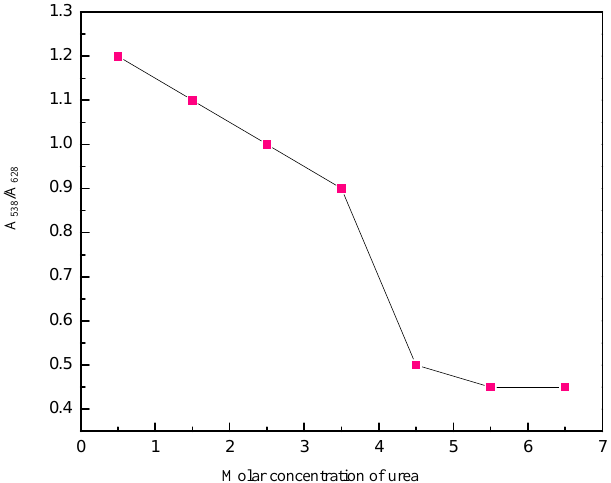
Figure 9. Reversal of metachromasy in AO-NaCar system on addition of urea